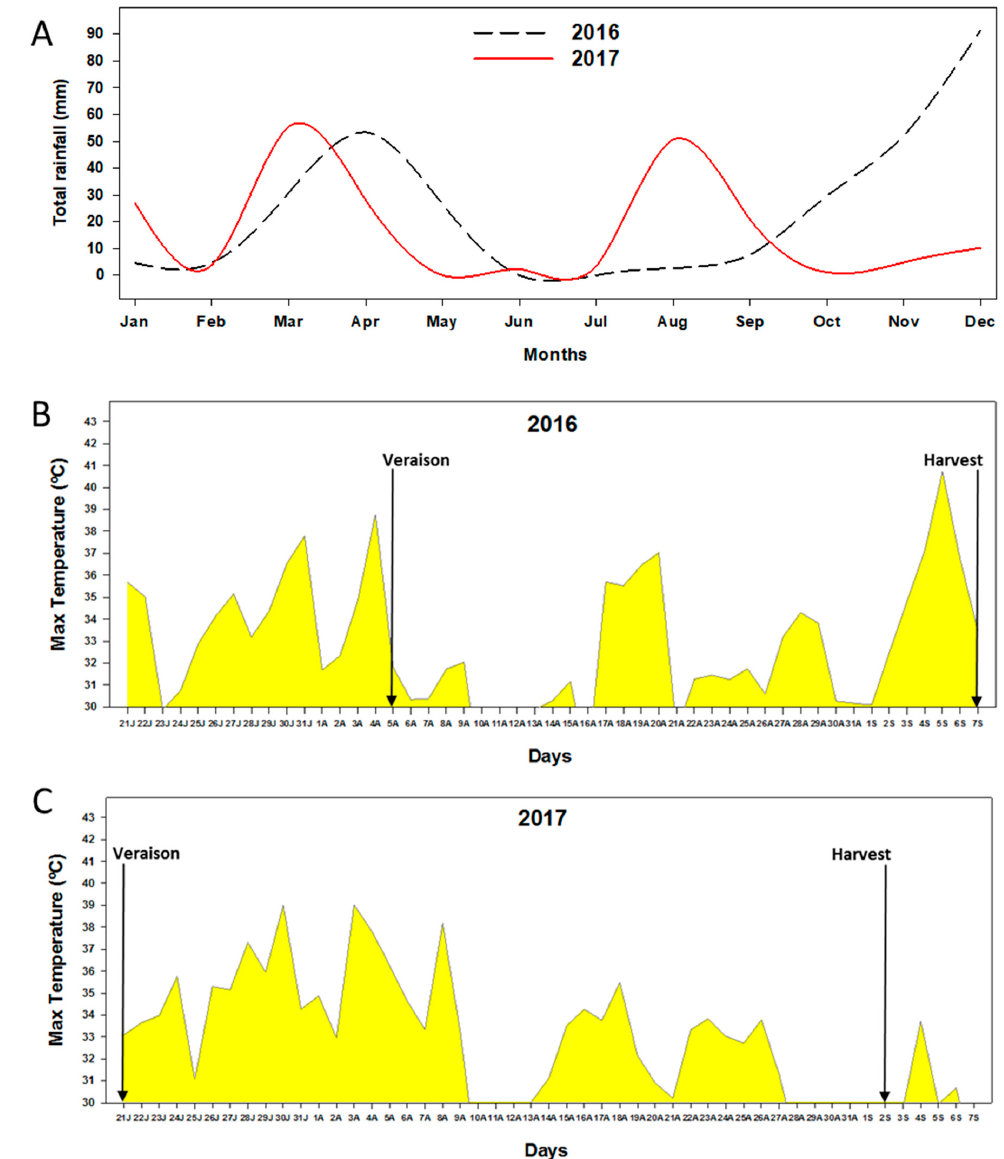
Figure 1. ( A ) Monthly evolution of rainfall recorded on the experimental farm during 2016 and 2017. ( B ) Daily evolution of maximum temperatures (above 30 °C) recorded on the experimental farm during 2016. ( C ) Daily evolution of maximum temperatures (above 30 °C) recorded on the experimental farm during 2017.